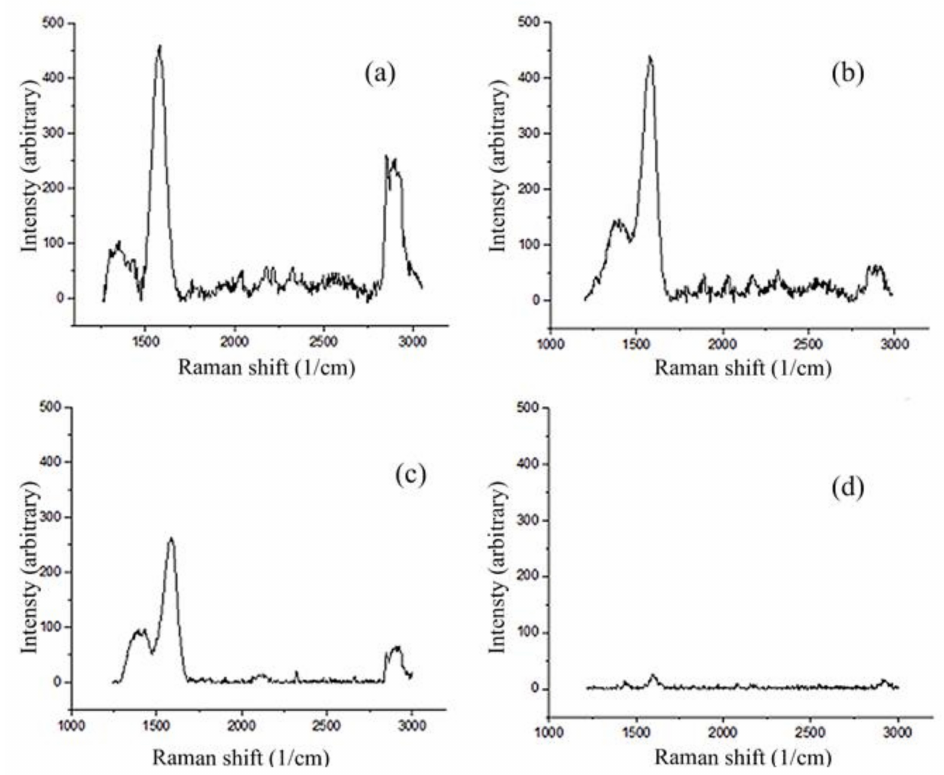
Figure 11. Raman spectroscopy of composite coating: ( a ) coated surface; ( b ) coated scratch; ( c ) coated heat-treated surface; ( d ) coated heat-treated